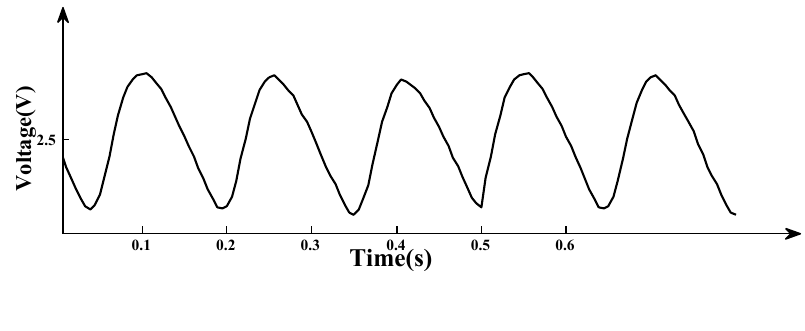
Figure 5. Waveform after digital filtered.